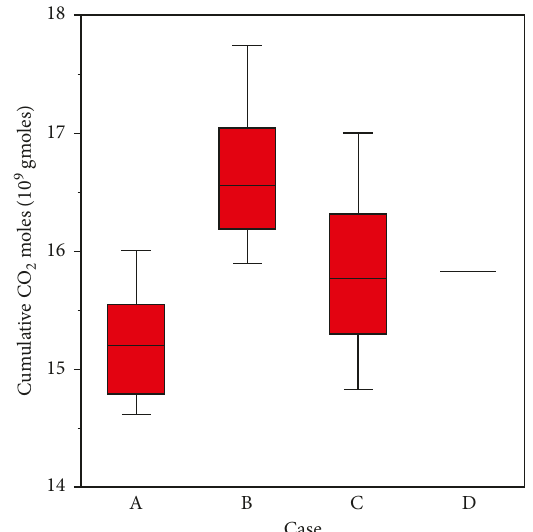
Figure 8: Box-whisker plots of sequestered CO